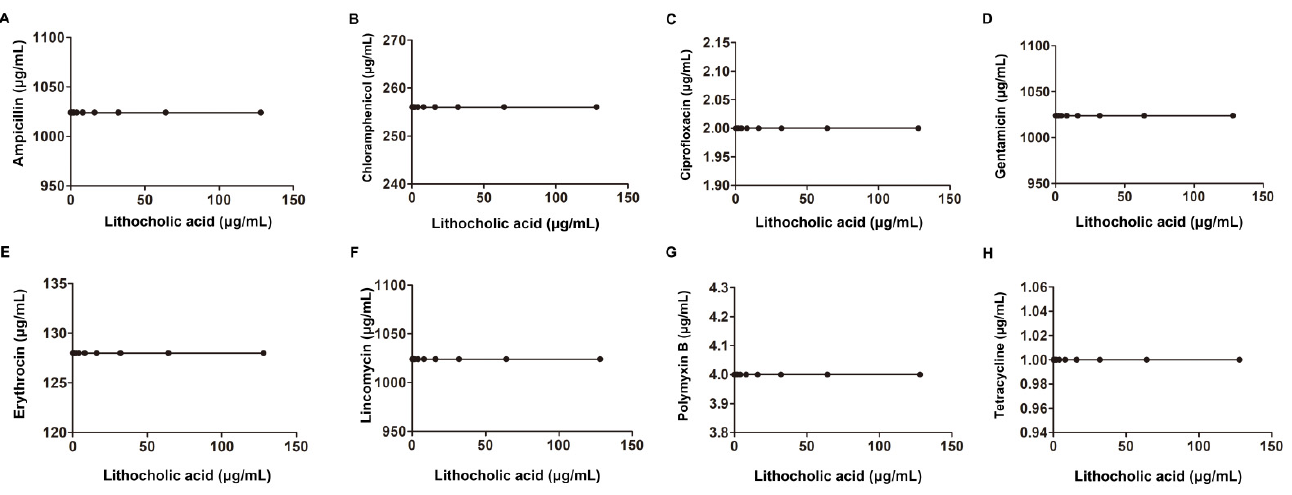
Figure 6. Interaction of LCA with Amp, Ery, Genta, Cip, Lin, Tet, Cpl and Pmb against Acinetobacter baumannii ATCC19606 ( A – H ).